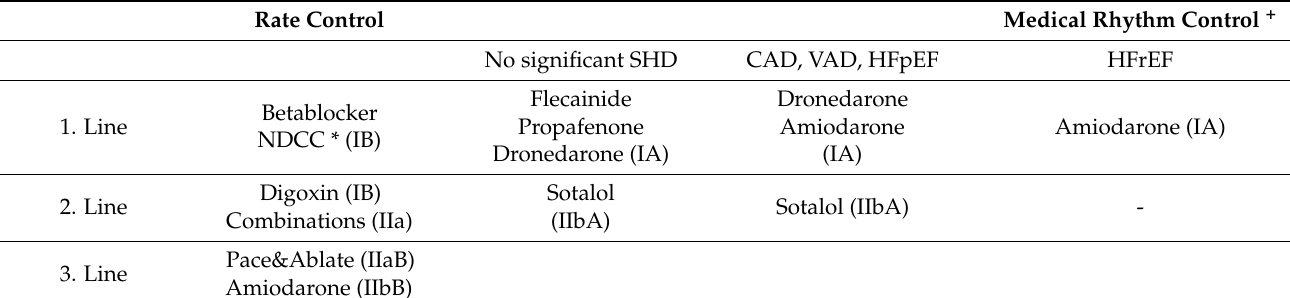
Table 1. Medical rate and rhythm control options in AF